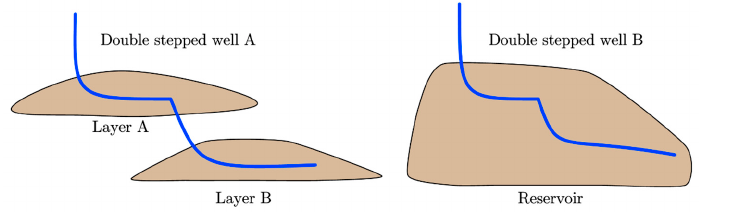
Figure 9. Double stepped well in thin interbed reservoir and massive thick reservoir with strongly heterogeneous features.